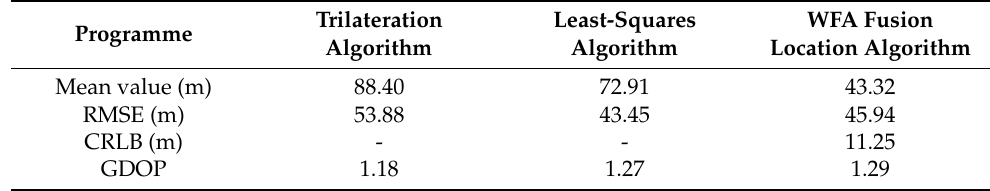
Table 6. Positioning accuracy evaluation index.